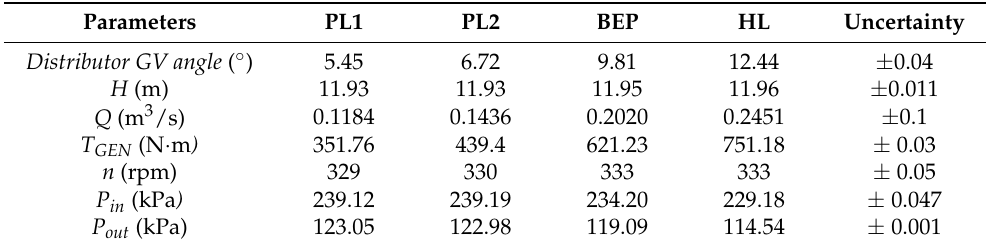
Table 2. Mean operational parameters of the Francis turbine model without the GV